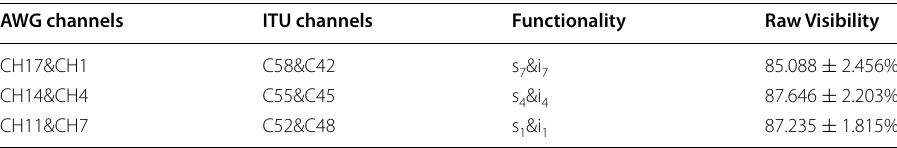
Table 2 Definition and quantum interference visibilities of the AWG channel pairs in the multi‑chip entanglement